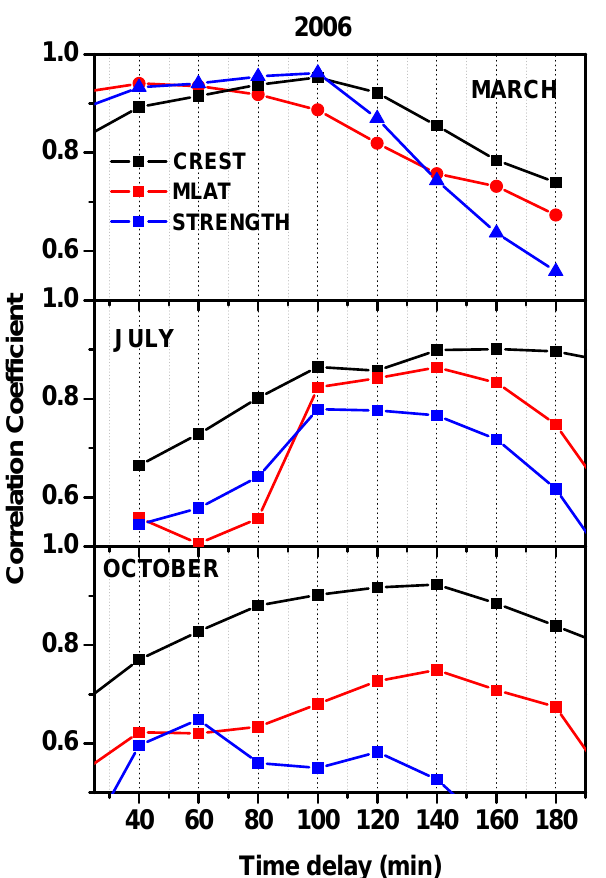
Fig. 3. Correlation between IEEJ and EIA parameters for different time delays.